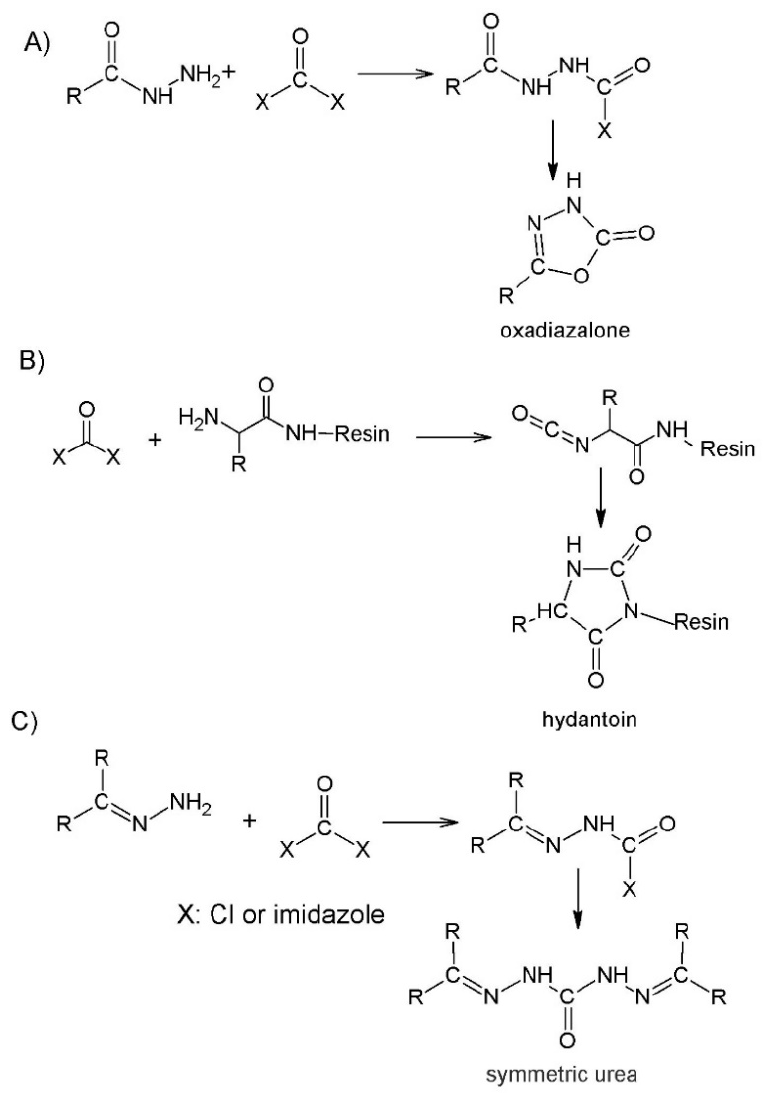
Figure 2. Possible side reactions during the azaamino acid coupling. The formation of side products— oxadiazalone ( A ), hydantoin ( B ) and symmetric urea ( C